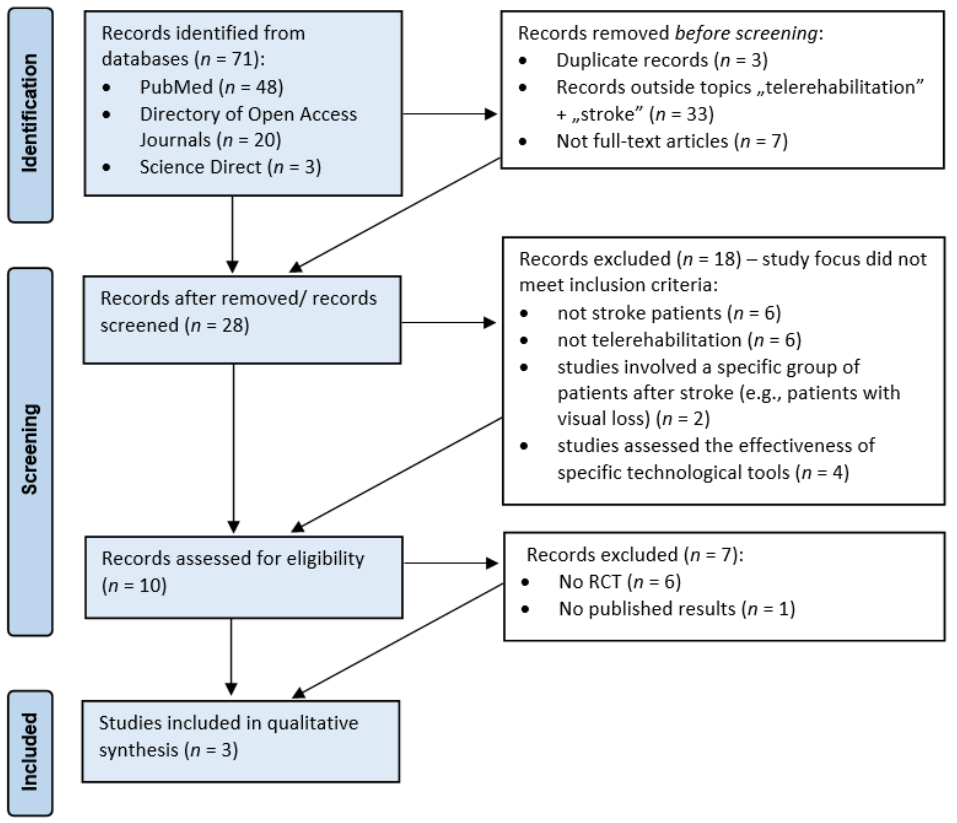
Figure 1. Flow diagram adapted from PRISMA which shows the process for identifying and screening the articles for inclusion and exclusion. Table 1. Description of articles initially included by PRISMA methodology.